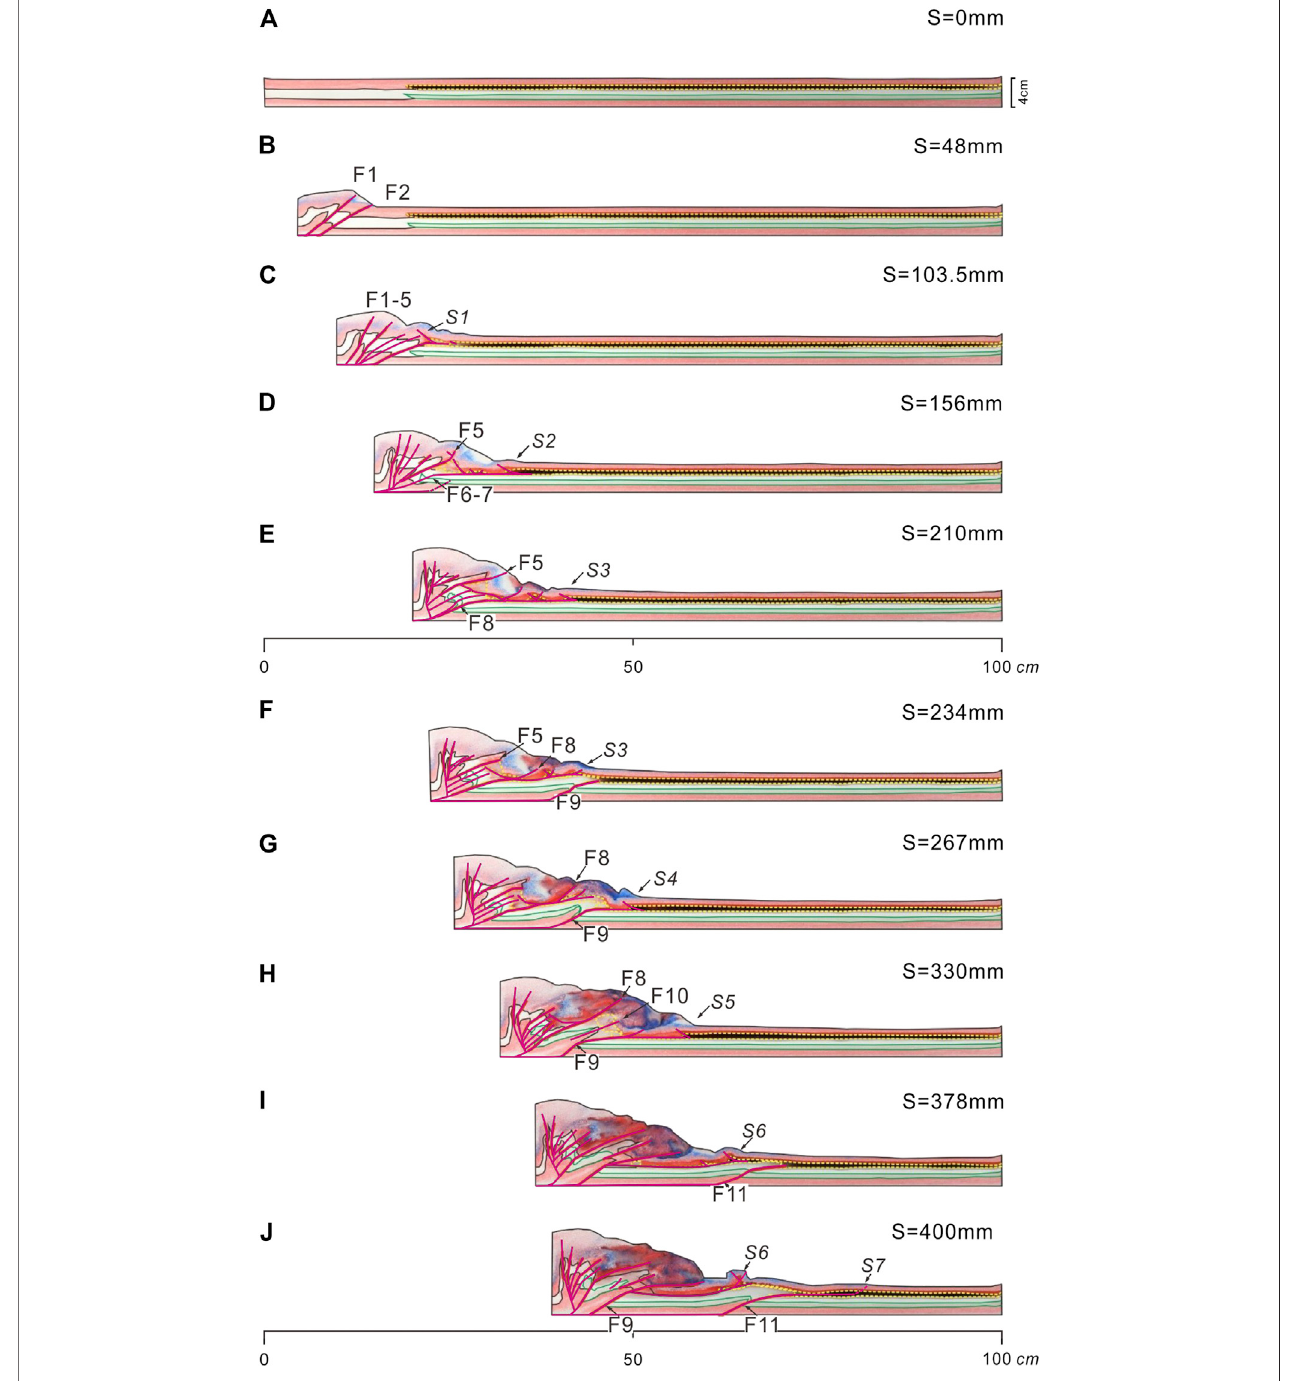
FIGURE 6 | Evolutionary stages of Exp. M2 that has a frictional MD (outlined by green line). The yellow dash line outlines the viscous SD. A frictional BD was also added on the base of the model. Uppercase letters S and F are used to represent folds involving the shallow structural level (above the SD) only and thrusts nucleated from the basal décollement. (A – B) initial stacking of small thrust slices in the right; (C – E) deformation started to affect the shallow structural level (above the SD). Synchronously,smallthrustsF6 – 7nucleatedbeneaththeSD; (F – J) Asynchronousdeformationpropagationintheshallowanddeeperstructurallevels.Thedeeper faults in these stages showed much large spaces than the former